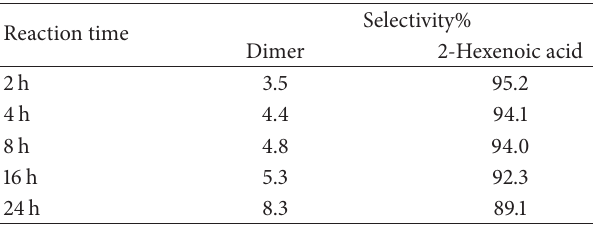
Table 4: Effect of reaction time on the selectivity during the oxidation of 2-hexenal using 1% Au/MnO 2